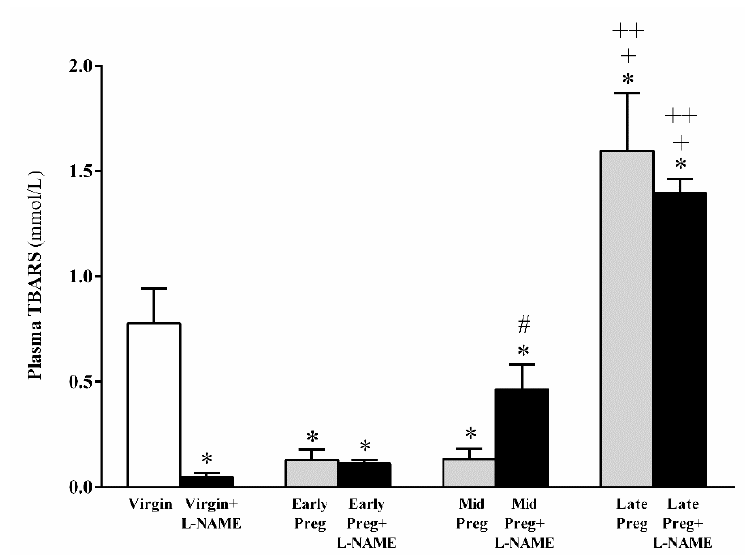
Figure 3. Oxidative stress of virgin rats and Early, middle (Mid) and Late-pregnant rats treated with saline or L-NAME. Values represent mean ± SEM. * P < 0.05 versus Virgin group, # P < 0.05 versus the Mid-Preg group, + P < 0.05 versus Early-Preg and Early-Preg + L-NAME groups, and ++ P < 0.05 versus Mid-Preg and Mid-Preg + L-NAME groups.